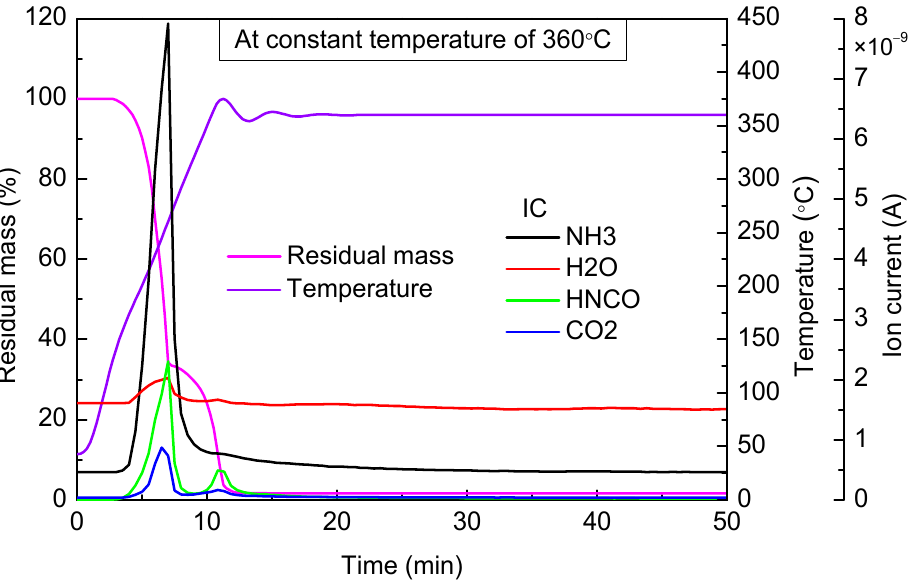
Figure 9. TG-MS results of urea at constant temperature of 360 °C.